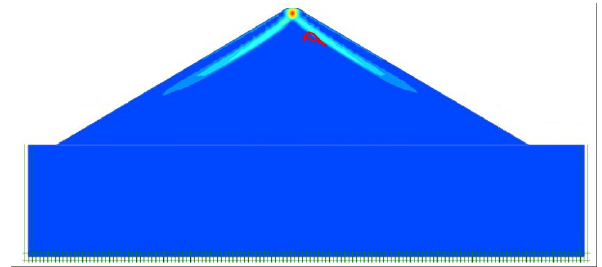
Figure 13: An outline of a macropore from test of model type 2, su- perimposed over a theoretical destruction mechanism, obtained using the strength reduction